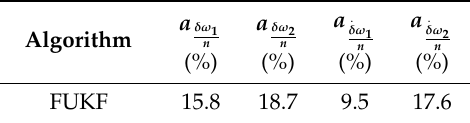
Figure 8. Experimental transients of the speeds estimation errors for the UKF and FUKF estimators: